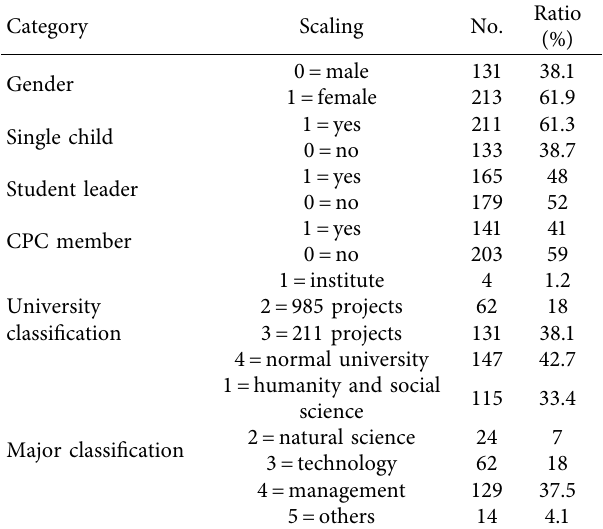
Table 1: Control variable scaling and